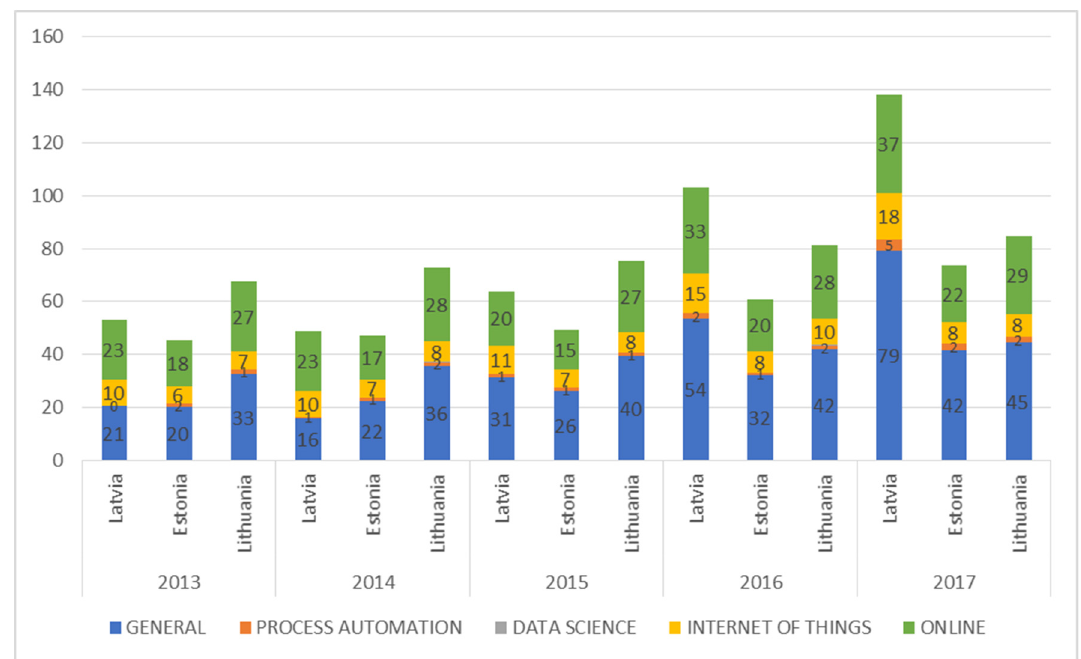
Figure 4. The structure of elements forming digital maturity in Baltic States.